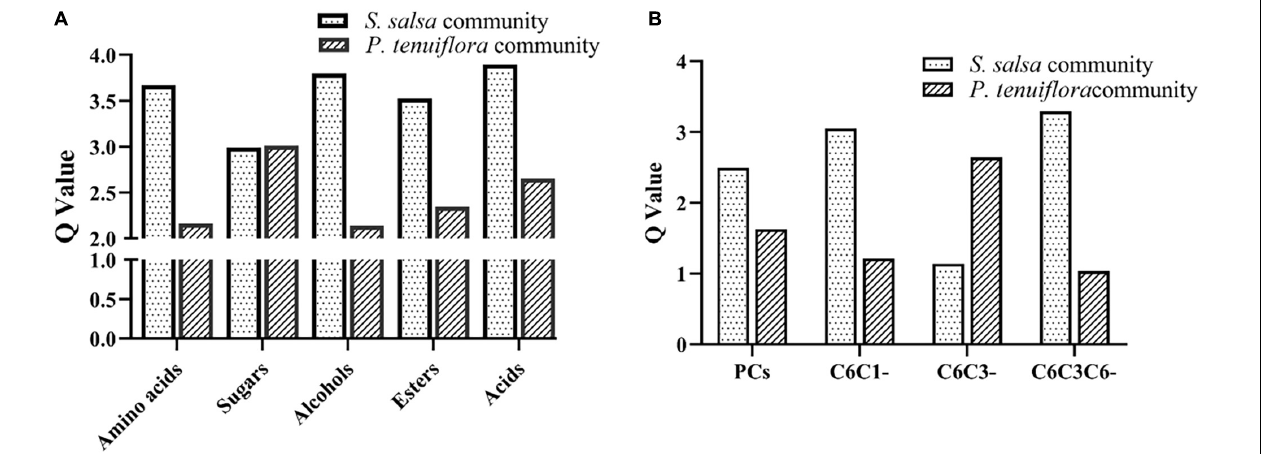
FIGURE 4 | The Q -values of significantly different metabolisms between S. salsa community and P. tenuiflora community: (A) the Q -values of significantly primary different metabolisms between S. salsa community and P. tenuiflora community; (B) the Q -values of a phenolic compounds C6C1-compounds, C6C3-compounds, and C6C3C6-compounds; PCs, phenolic